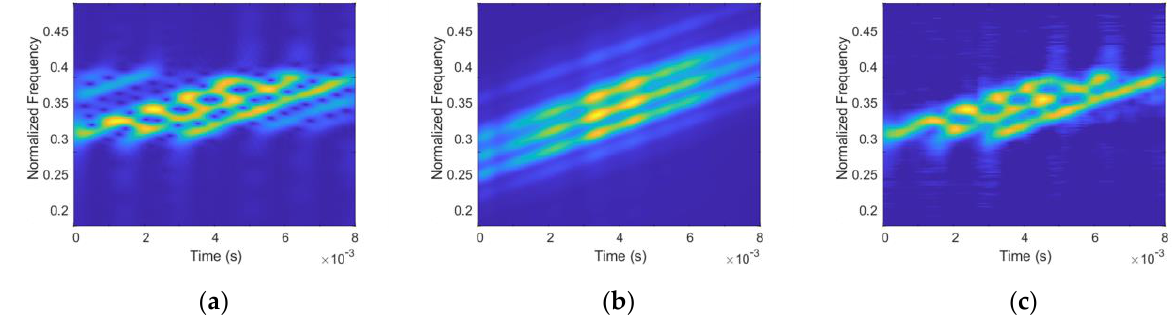
Figure 8. Reverberation suppression results for the signal with three highlights: ( a ) input signal; ( b ) output of the NMF method; ( c ) output of ACANet.